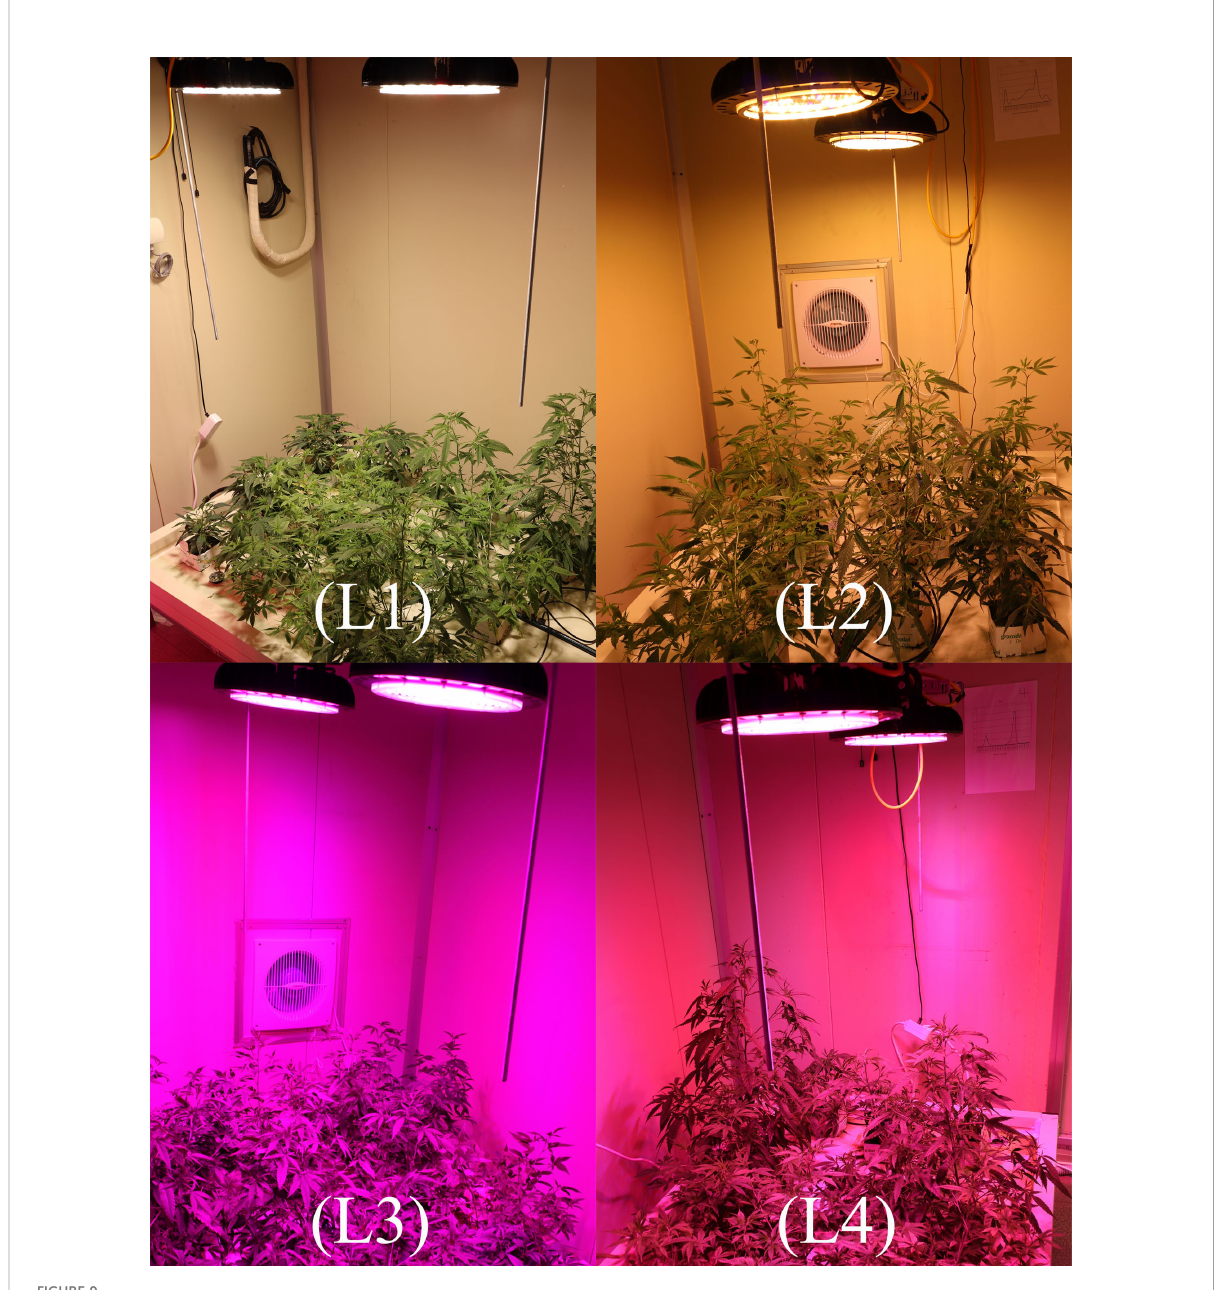
FIGURE 9 Effect of LED light on growth and morphological traits of hemp plants at 30 DAT. L1, MW 240 (Red 35% + Blue 25% + Green 40%); L2, FS 240- UV (Red 40% + UVA and Blue 26% + Green 29% + Far red 5%); L3, MB 240 (Red 85% + Blue 15%); L4, PF 240 (Red 70% + Blue